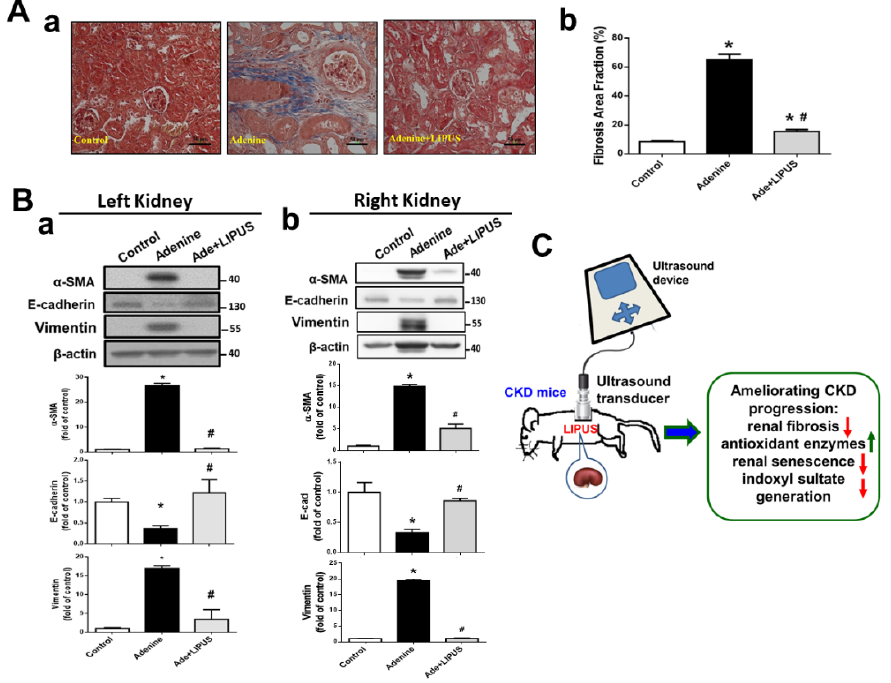
Figure 7. The effects of LIPUS on renal fibrosis and fibrosis-related signaling molecules in CKD mouse models following adenine administration: ( A ) ( a ) renal fibrosis stained by Masson’s trichrome in the left kidneys and ( b ) quantifications (scale bar: 50 µ m; data are presented as mean ± SD (n = 10); * p < 0.05 versus the control group; # p < 0.05 versus the CKD-alone group); ( B ) protein expression levels for α -SMA, E-cadherin, and vimentin in both left ( a ) and right ( b ) kidneys of the adenine- induced CKD mice, determined by Western blot, and quantifications for the protein expression (data are presented as mean ± SD (n = 4–6); * p < 0.05 versus the control group; # p < 0.05 versus the CKD-alone group); ( C ) a schematic summary of our main findings regarding the effects of LIPUS on CKD-associated renal injury. Green upward arrows represent up-regulation. Red downward arrows represent